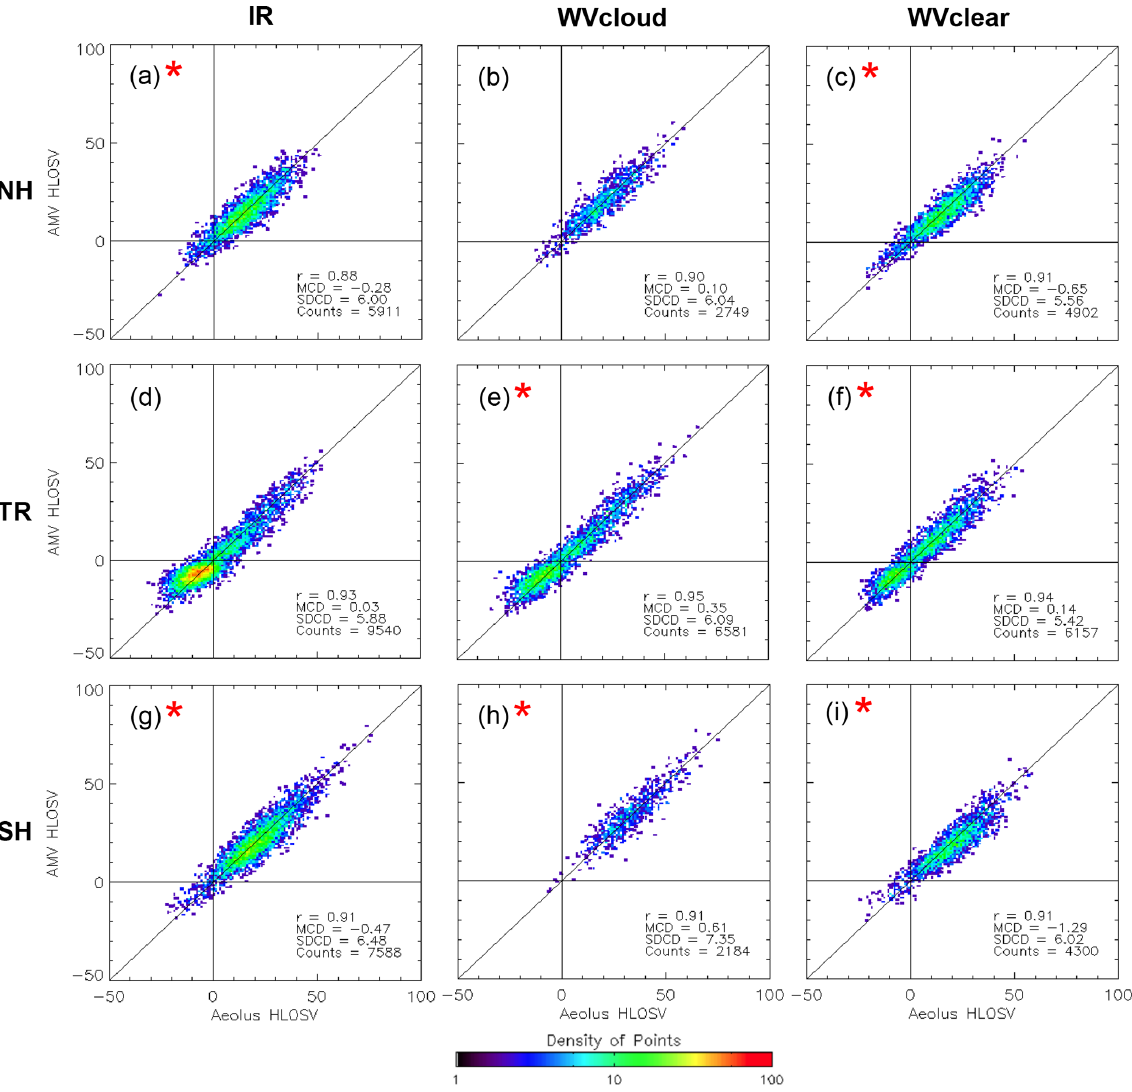
Figure 6. Density scatterplots of co-located GOES-16 AMVs and RAY winds. Rows are for the (a–c) NH extratropics (30–60 ◦ N), (d–f) trop- ics (TRs; 30 ◦ S to 30 ◦ N), and (g–i) SH extratropics (30–60 ◦ S). Columns are for different AMV types, including (a, d, g) IR, (b, e, h) WV- cloud, and (c, f, i) WVclear. Colors indicate total number of co-located observation pairs within the cells plotted, which are 1ms − 1 on a side. Sample statistics are displayed in the bottom right corner of each panel. Horizontal and vertical zero lines are plotted in black, as is the diagonal one-to-one line. The red star denotes statistical significance at 95%, using the paired two-tailed Student’s t test. HLOSV units are in meters per second (hereafter ms − 1